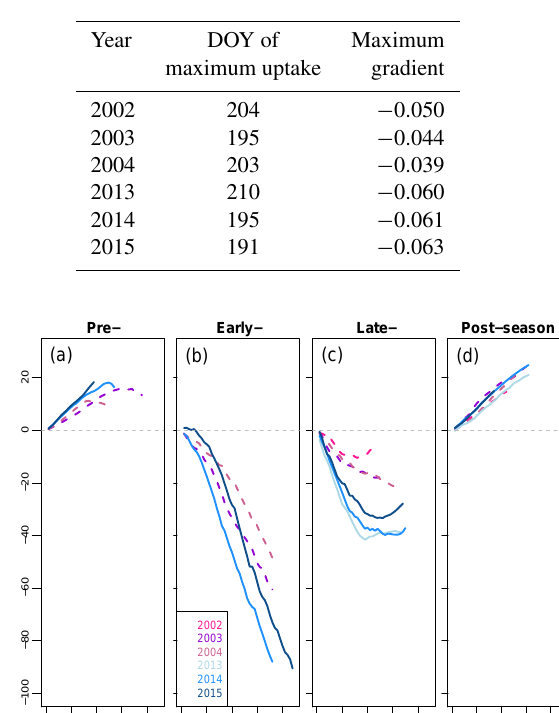
Table 2. Results from the linear regression of cumulative CO 2 fluxes during the growing season with day of year (DOY) of maxi- mum gradient and maximum gradient slope.